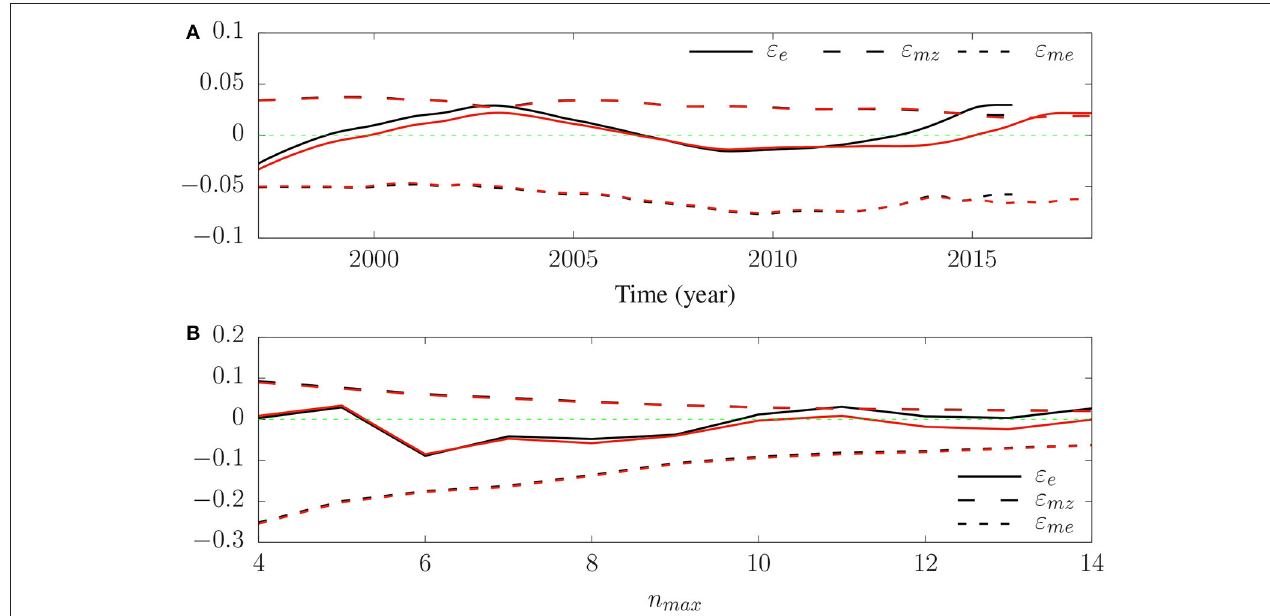
FIGURE 8 | The ratios ε e (solid lines), ε mz (dashed lines), and ε me (dotted lines) for the models CHAOS-5 (black ; Finlay et al., 2015) and CHAOS-6 (red ; Finlay et al., 2016b ) as a function of time for n max = 14 (A) and as a function of n max for the year 2015 (B)